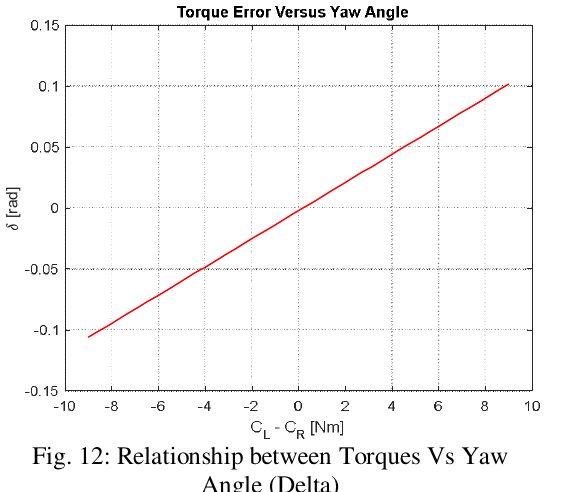
Fig. 12: Relationship between Torques Vs Yaw Angle (Delta)